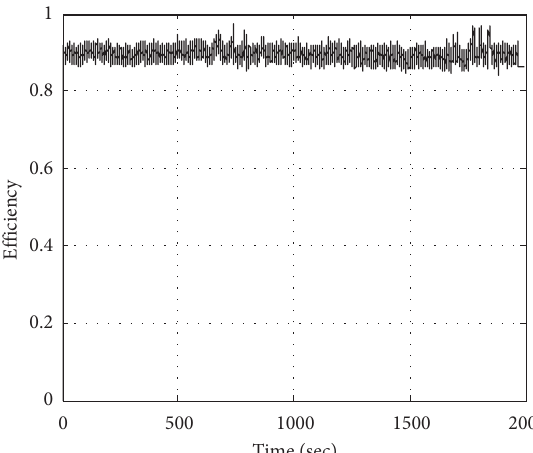
Figure 22: Efficiency of the Pv system.